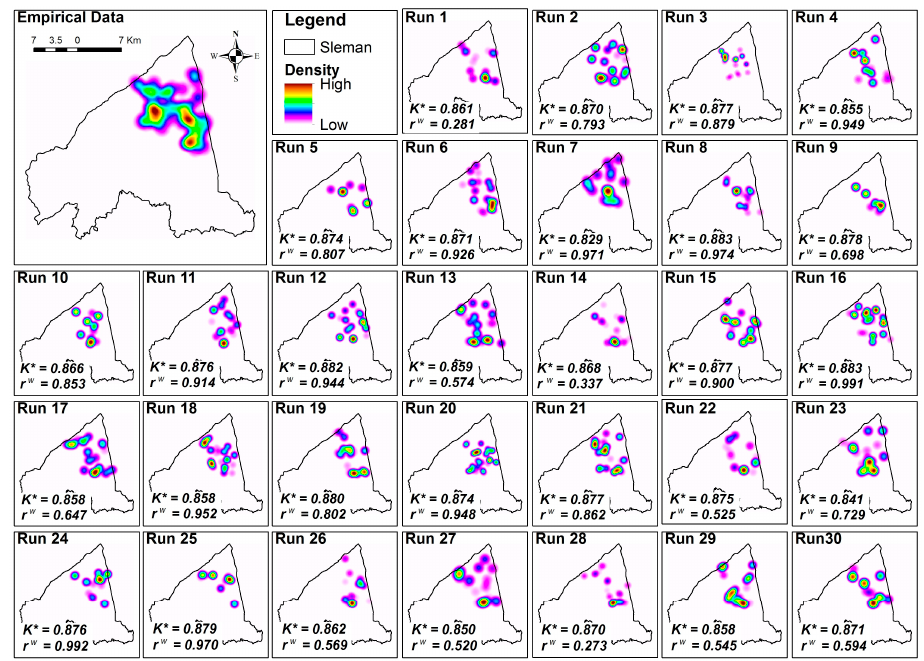
Figure 12. Spatial comparison of simulated and observed reluctance distribution based on scenario 3.